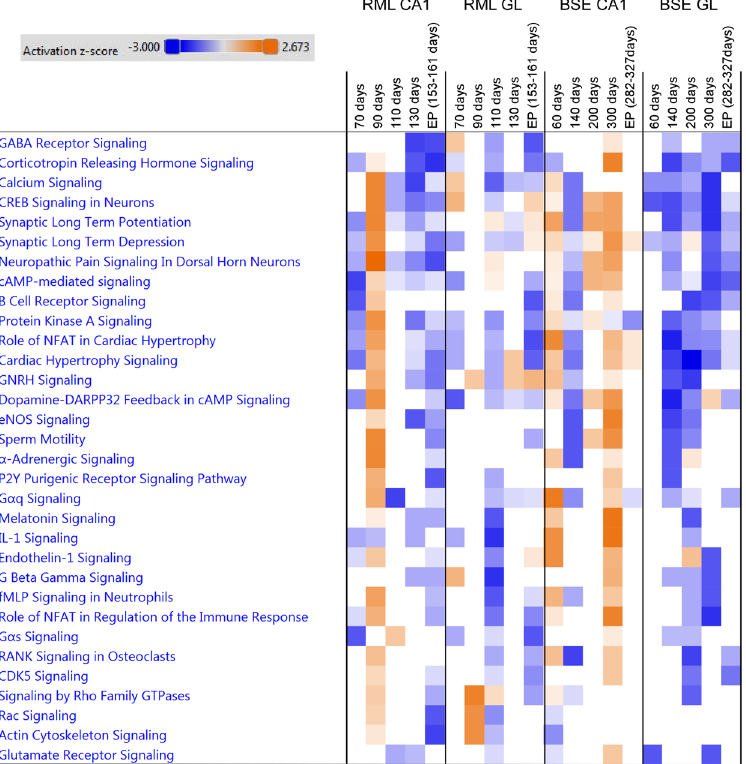
Figure 6. Comparison analysis of canonical signaling pathways temporally activated in neurons during prion infection. Heat map showing top activated canonical pathways generated using genes with expression enriched in neurons during prion infections. Upregulated pathways are shaded orange, down-regulated pathways are shaded blue. The intensity indicates the degree that each gene was up-regulated or down-regulated as determined by the IPA determined